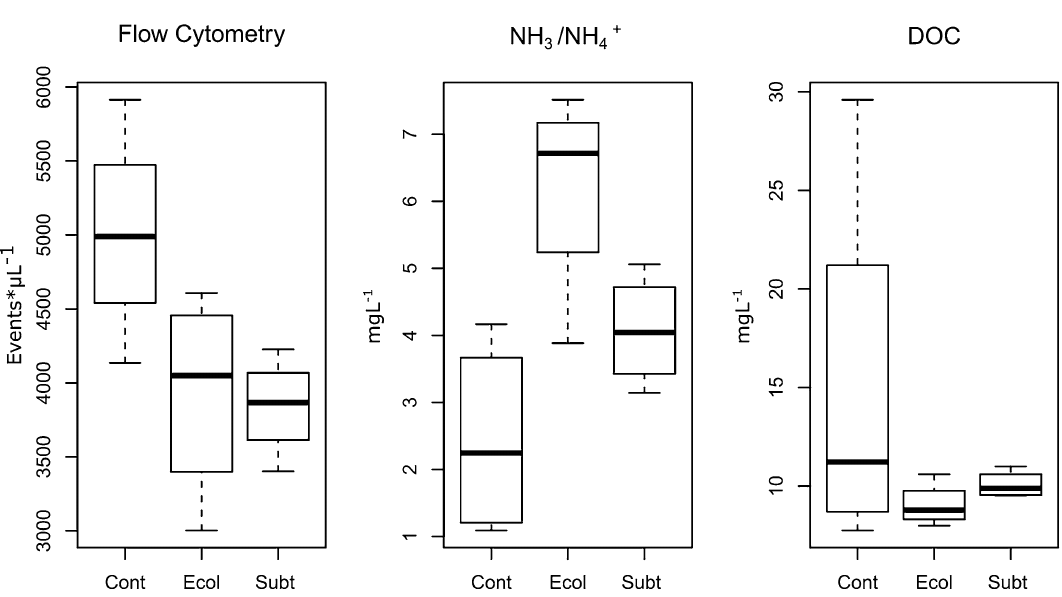
Figure 3. Boxplots of water parameters that were significantly associated with the ASV ordination. Cont: Control; Ecol: E . coli DH5α; Subt: P . rubra SubTr2. Flow cytometry-ANOVA: F 2,9 = 4.46, P = 0.04; NH 3 /NH 4+ - ANOVA: F 2,9 = 7.88, P = 0.01; DOC (Dissolved organic carbon)-PERMANOVA: F 2,9 = 1.17, P =